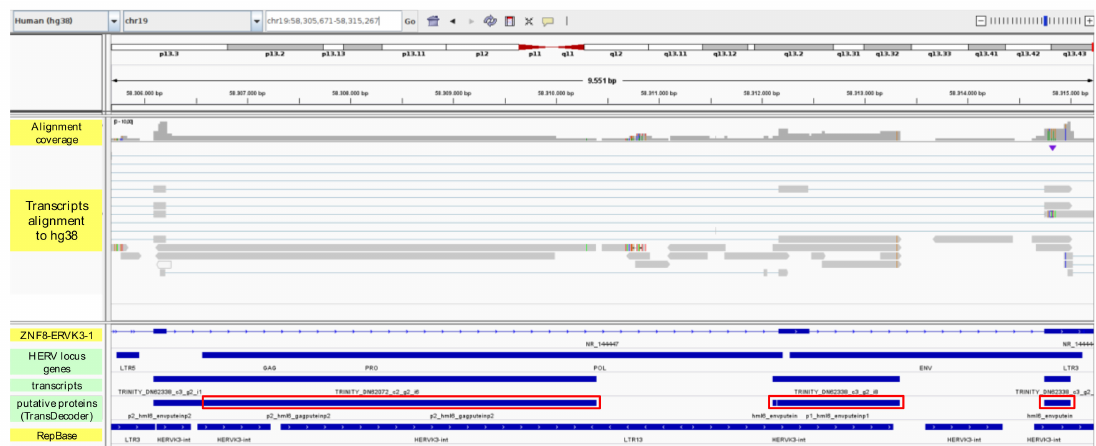
Figure 4. Focus on the puteins encoded by HML6 locus 4796. Puteins and the originating transcripts have been aligned to the locus genomic position, annotated with the retroviral genes as previously identified [43]. The presence of human genes (Gencode version 32) and repetitive elements (RepBase) is also indicated. The puteins overlapping with reported exons are highlighted with a red rectangle.